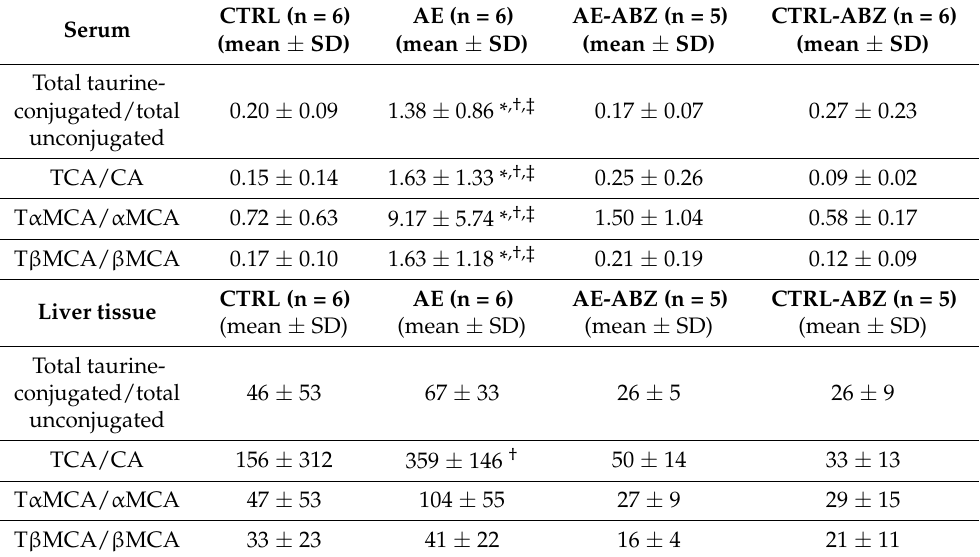
Figure 2. Increased ratio of taurine-conjugated to unconjugated bile acids in AE. The sum of the taurine-conjugated bile acids divided by the sum of unconjugated bile acids was determined in the four different treatment groups, in serum samples ( A ) and liver tissues ( B ). Non-infected control (CTRL, n = 6), E. multilocularis -infected (AE, n = 6), E. multilocularis -infected and ABZ-treated (AE-ABZ, n = 5, one outlier with aberrant concentrations was removed), and non-infected and ABZ-treated control mice (CTRL-ABZ, n = 6 in serum and n = 5 in liver tissue due to exclusion of an outlier). Values are expressed as mean ± SD. * p < 0.05 and ** p < 0.01. Table 3. Increased ratio of taurine-conjugated to unconjugated bile acids in AE. The ratio of total taurine-conjugated to total unconjugated bile acids as well as the ratios of TCA/CA, T α MCA/ α MCA, and T β MCA/ β MCA were calculated for the four different treatment groups in the serum and liver tissue samples. Non-infected control (CTRL, n = 6), E. multilocularis -infected (AE, n = 6), E. multilocularis -infected and ABZ-treated (AE-ABZ, n = 5, one outlier with aberrant concentrations was removed), and non-infected and ABZ-treated control mice (CTRL-ABZ, n = 6 in serum and n = 5 in liver tissue due to exclusion of an outlier). Values are expressed as mean ± SD. * p < 0.05 AE vs. CTRL, † p < 0.05 AE vs. CTRL-ABZ, and ‡ p < 0.05 AE vs. AE-ABZ .